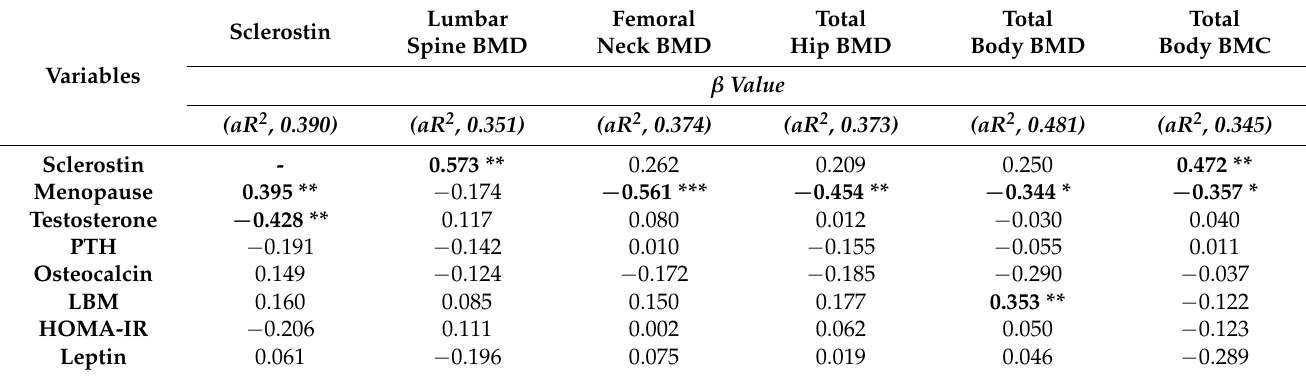
Table 5. Multivariable regression analysis in merged study groups. Results are provided for variables in the regression equa- tion, adjusted R 2 values for significant predictors, standardized coefficients ( β ) and p values, with significant associations shown in bold character. For menopause: 0 = no, 1 = yes. For significance: *, p < 0.05; **, p < 0.01, ***, p < 0.001.